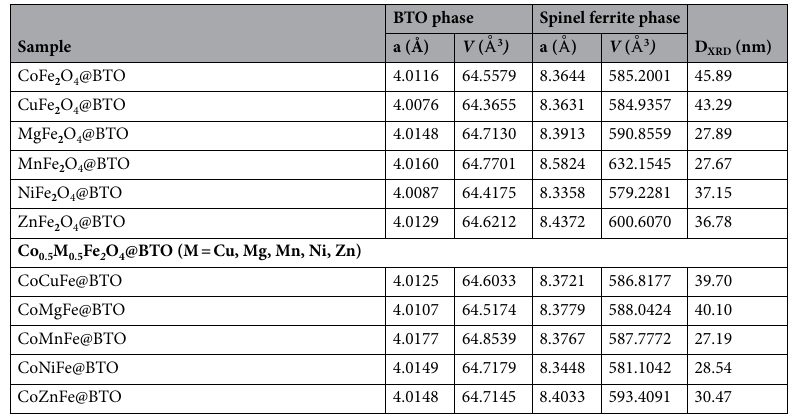
Table 1. The lattice parameters and crystallite size of core–shell (MFe 2 O 4 @BTO, CoMFe@BTO; M = Mn, Ni, Mg, Cu, Zn, or Co) MENCs.